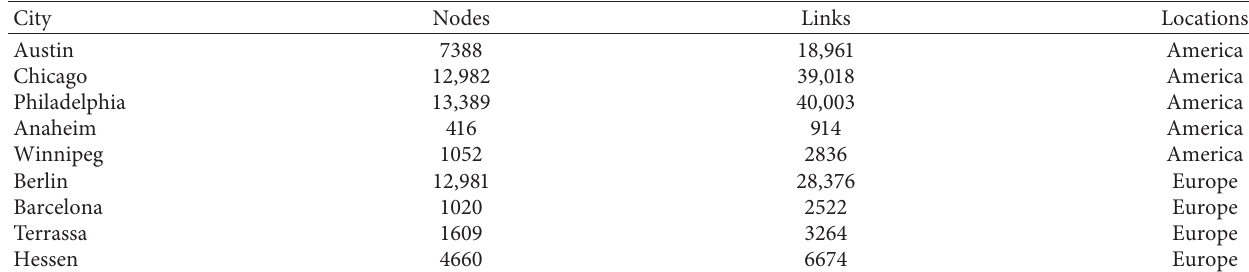
Table 1: Urban road networks with different